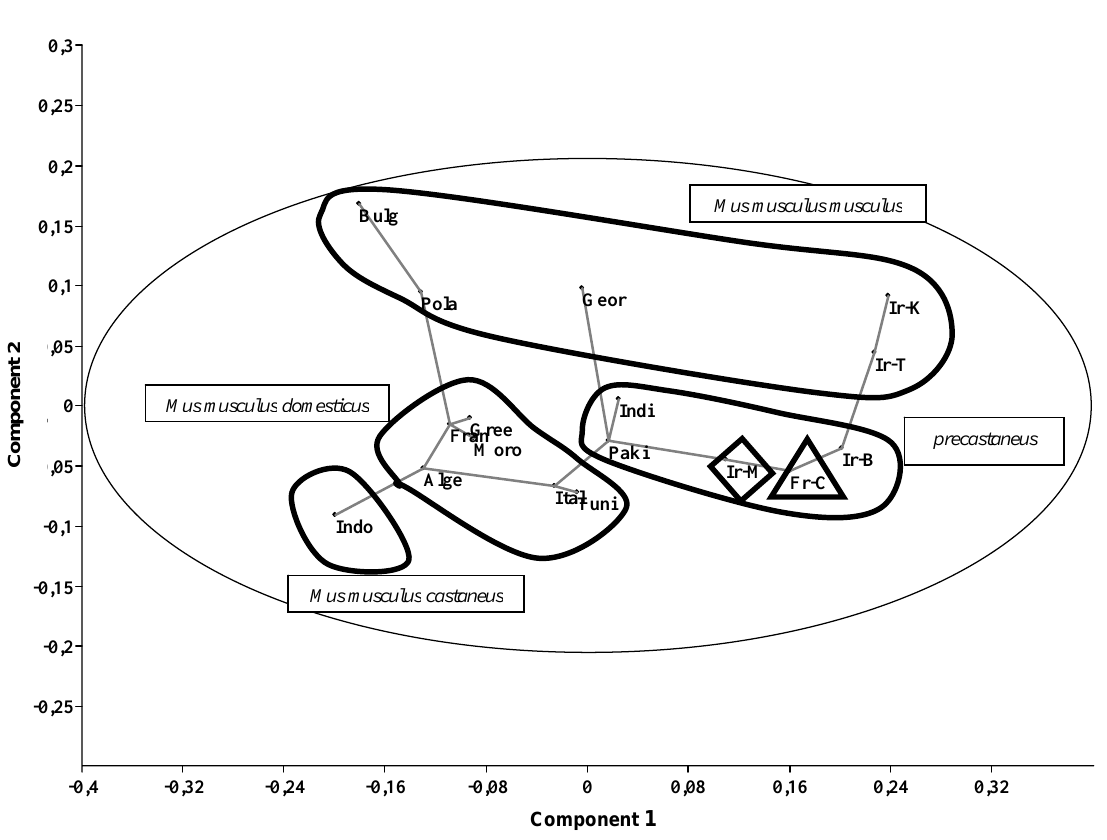
F IG .6. – Phenetic variation in house mouse. Results of principal component analysis of